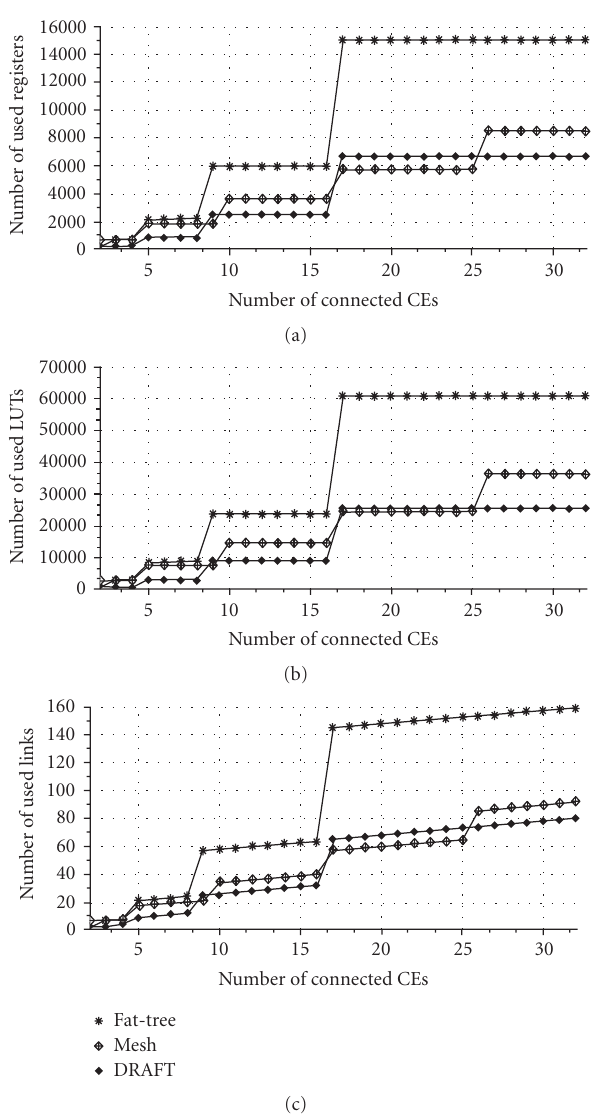
Figure 11: Number of registers (a), LUTs (b), and links (c) used for DRAFT, fat-tree, and mesh implementations in a Xilinx Virtex5 depending on the number of connected